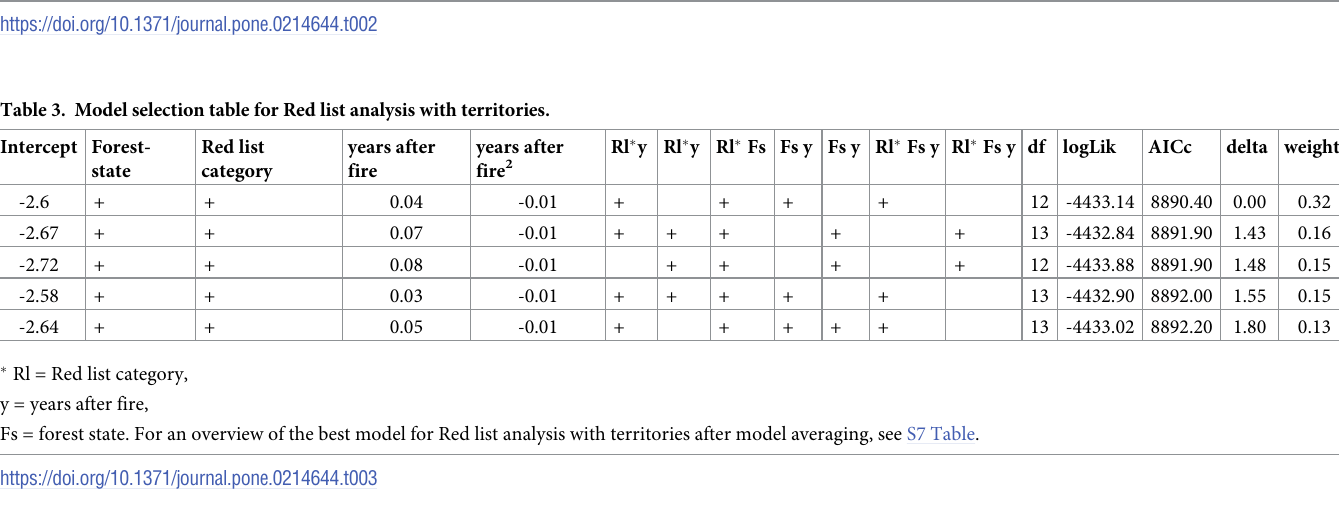
� For an overview of the best model for Red list analysis with index after model averaging, see S7 Table.